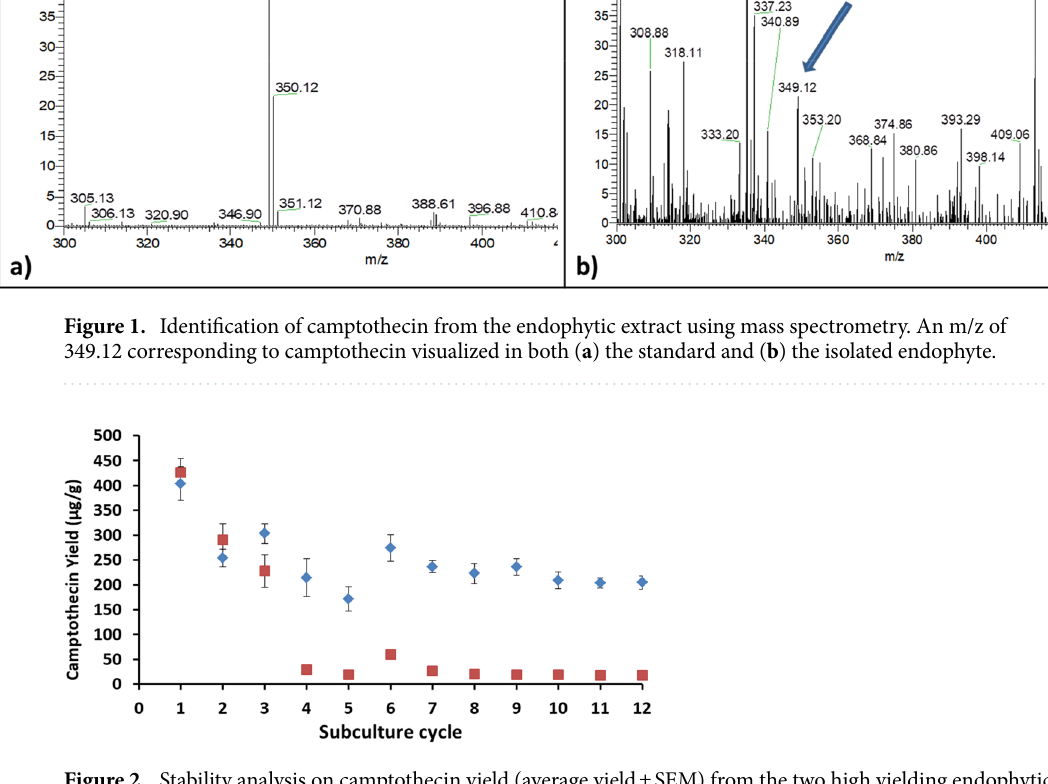
Figure 2. Stability analysis on camptothecin yield (average yield ± SEM) from the two high yielding endophytic strains ( A. burnsii NCIM1409 and A. alstroemeriae